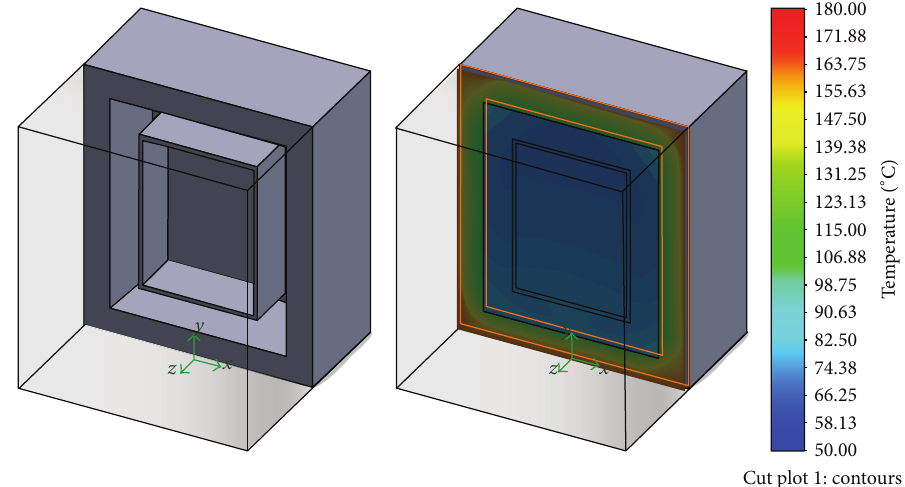
Cut plot 1 : contours